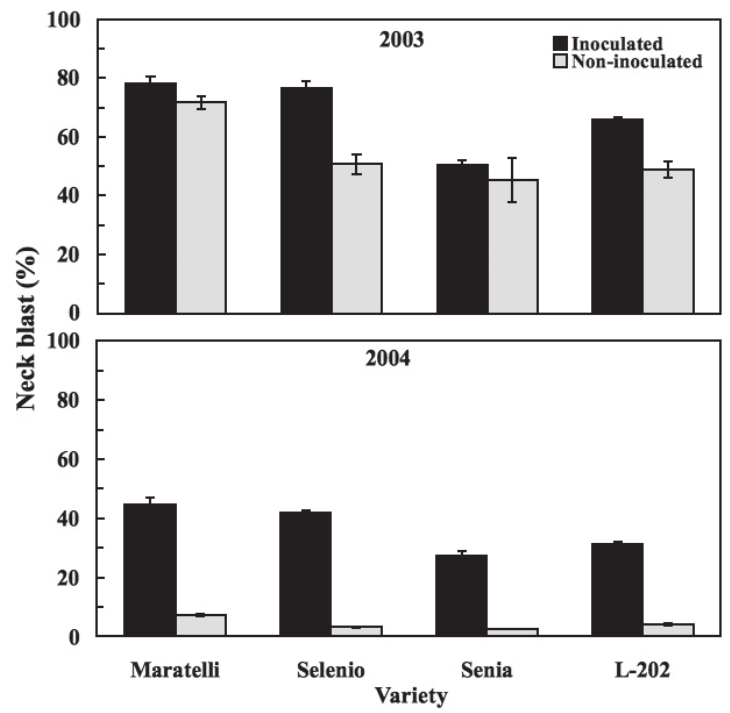
Fig. 2. Neck blast from Magnaporthe grisea 55 days after the time of 50% heading of four rice varieties, inoculated and non-inoculated with the fungus in field experiments conducted in 2003 and 2004. Error bars show the mean standard